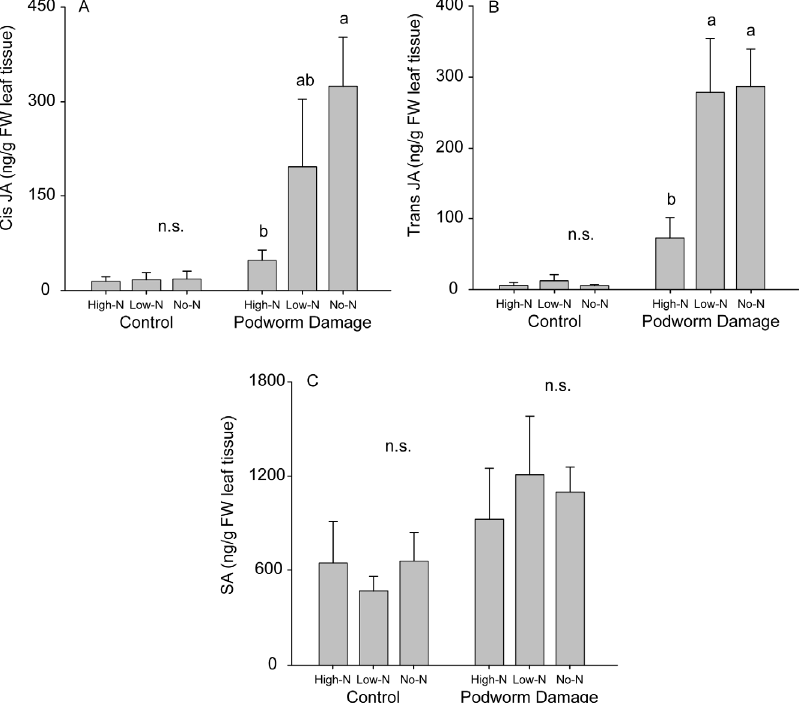
Figure 3. Phytohormone accumulation in undamaged (control) and podworm-damaged soybean with varying dependence on rhizobial N: ( A ) cis JA; ( B ) trans JA; ( C ) SA. High-N = High N fertilizer treatment, Low-N = Low N fertilizer treatment, and No-N = no fertilizer. Different lowercase letters indicate significant differences for that characteristic, while n.s. indicates no significant difference. Results shown as means ±